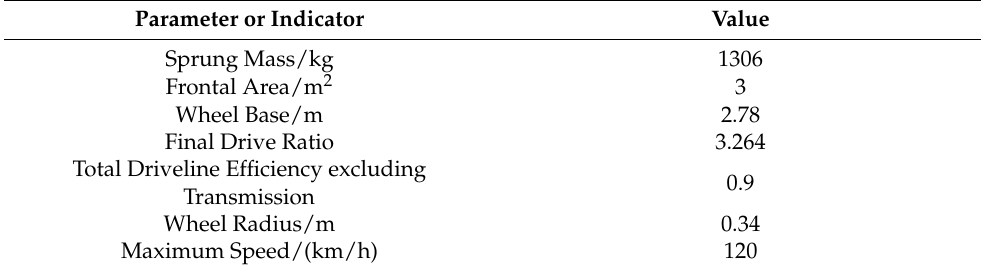
Figure 8. Transmission ratio control strategy model of SAT. Transmission ratio control strategy subsystems refer to Figure 7.